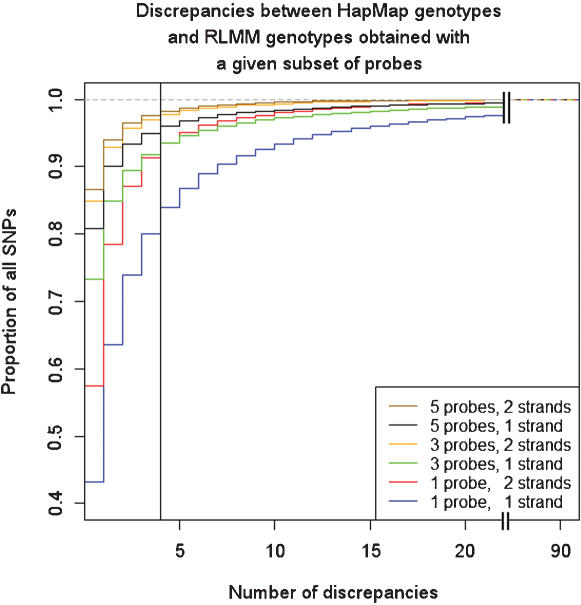
Cumulative distribution of discrepancies between HapMap and RLMM genotypes across probe set combinations Each curve shows the cumulative proportion of discrepancies between the 90 individuals for which genotypes were called using the indicated RLMM reduced probeset compared against the HapMap project. The vertical line at 4 discrepancies corresponds to approximately 95% specificity. 93.6% of all SNPs had 4 or fewer discrepancies when only the central probe on both strands was used (red curve). Note the break at 30 discrepancies, at which point 5 of the 6 curves have all but converged.